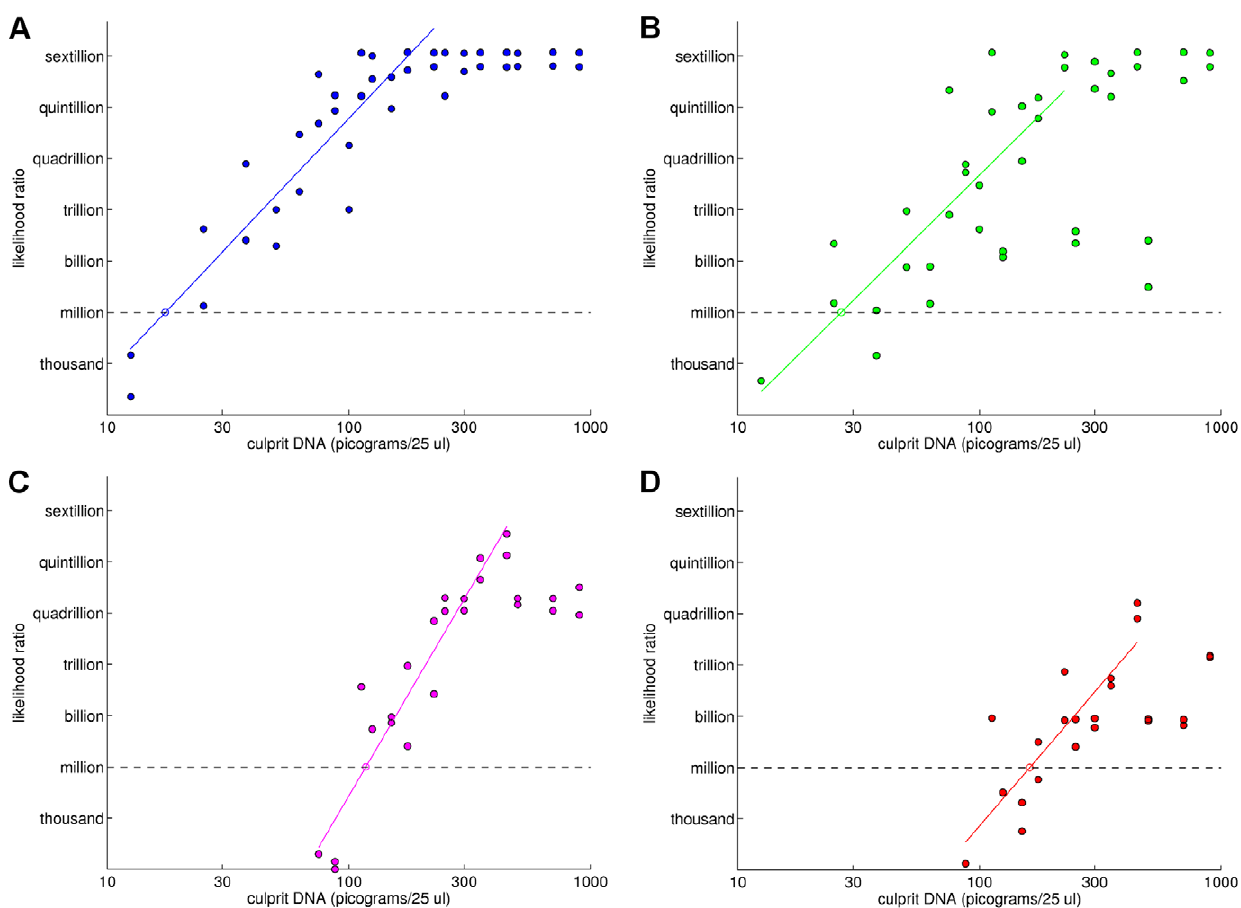
Figure 7. Determining DNA mass detection sensitivity by linear regression of match information versus DNA quantity. Scatter plots showing log(LR) match information (y-axis) versus log(culprit DNA) (x-axis) for four different mixture interpretation methods: (a) LR1 (blue), (b) LR2 (green), (c) CLR (purple), and (d) CPI (red). For each method, the scatter plots show an increasing ramp function that levels off when the maximum match information has been attained. The left ramp component is fitted to a regression line. The point at which this line intersects the horizontal million-to-one match information level gives the sensitivity of the interpretation method, measured in picograms of culprit DNA.